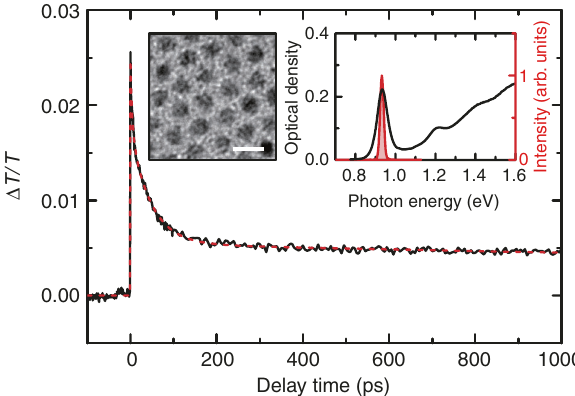
Fig. 1 Multiple exciton dynamics in a single pump-pulse measurement. Experimental (black solid curve) and calculated (red dotted curve) results of TA dynamics in PbS/CdS core/shell NCs for excitation with a single pump pulse. The insets show the transmission electron microscope image, scale bar: 10 nm, and the absorption spectrum of the nanocrystal sample. The spectrum of the pump pulse is shown with the red shaded